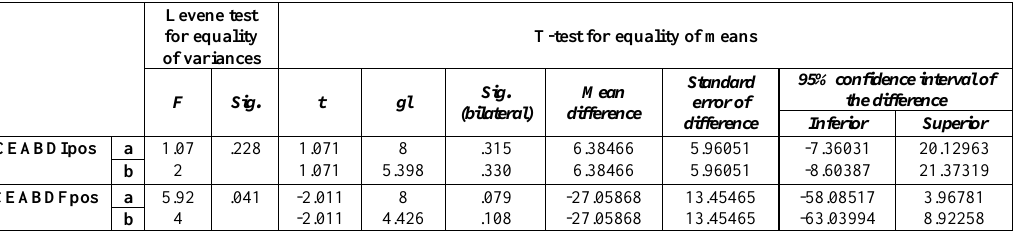
TABLE I. I NDEPENDENT SAMPLE TESTING - INITIAL AND FINAL ABDUCTION OF THE LEFT SHOULDER Levene test for equality of variances F Sig. t gl CEABDIpos a 1.07 2